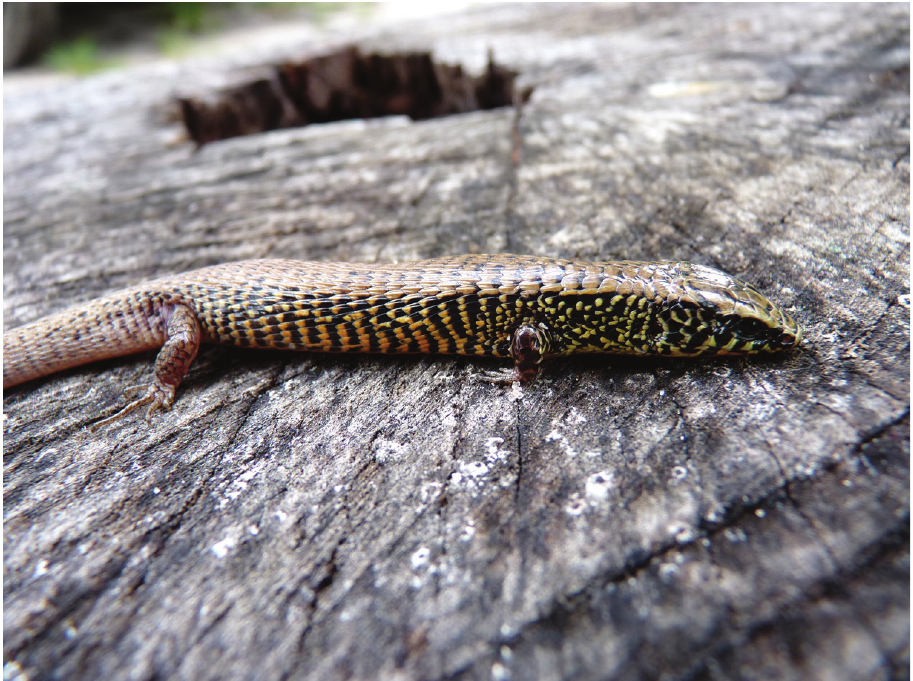
Figure 4. Specimen of Colobosaura modesta showing lateral coloration patter. Image given by Paul Smith (Fauna Paraguay). Additional photographs available at